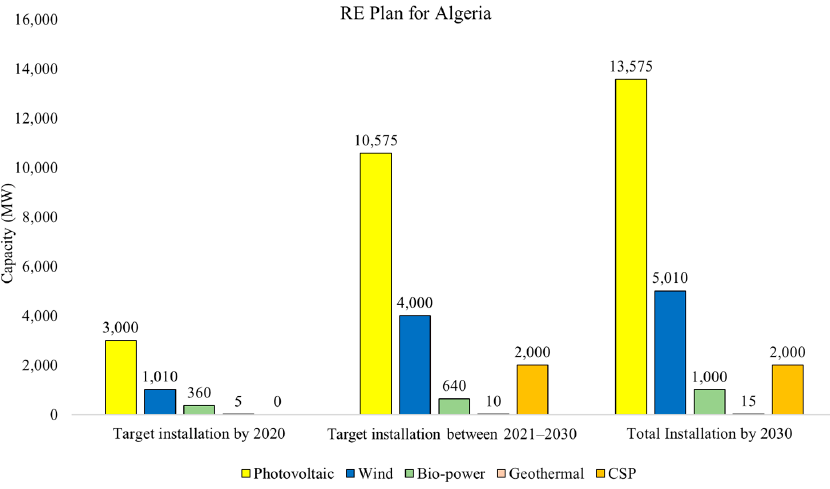
Figure 14. Algeria RE current and future generation plan.